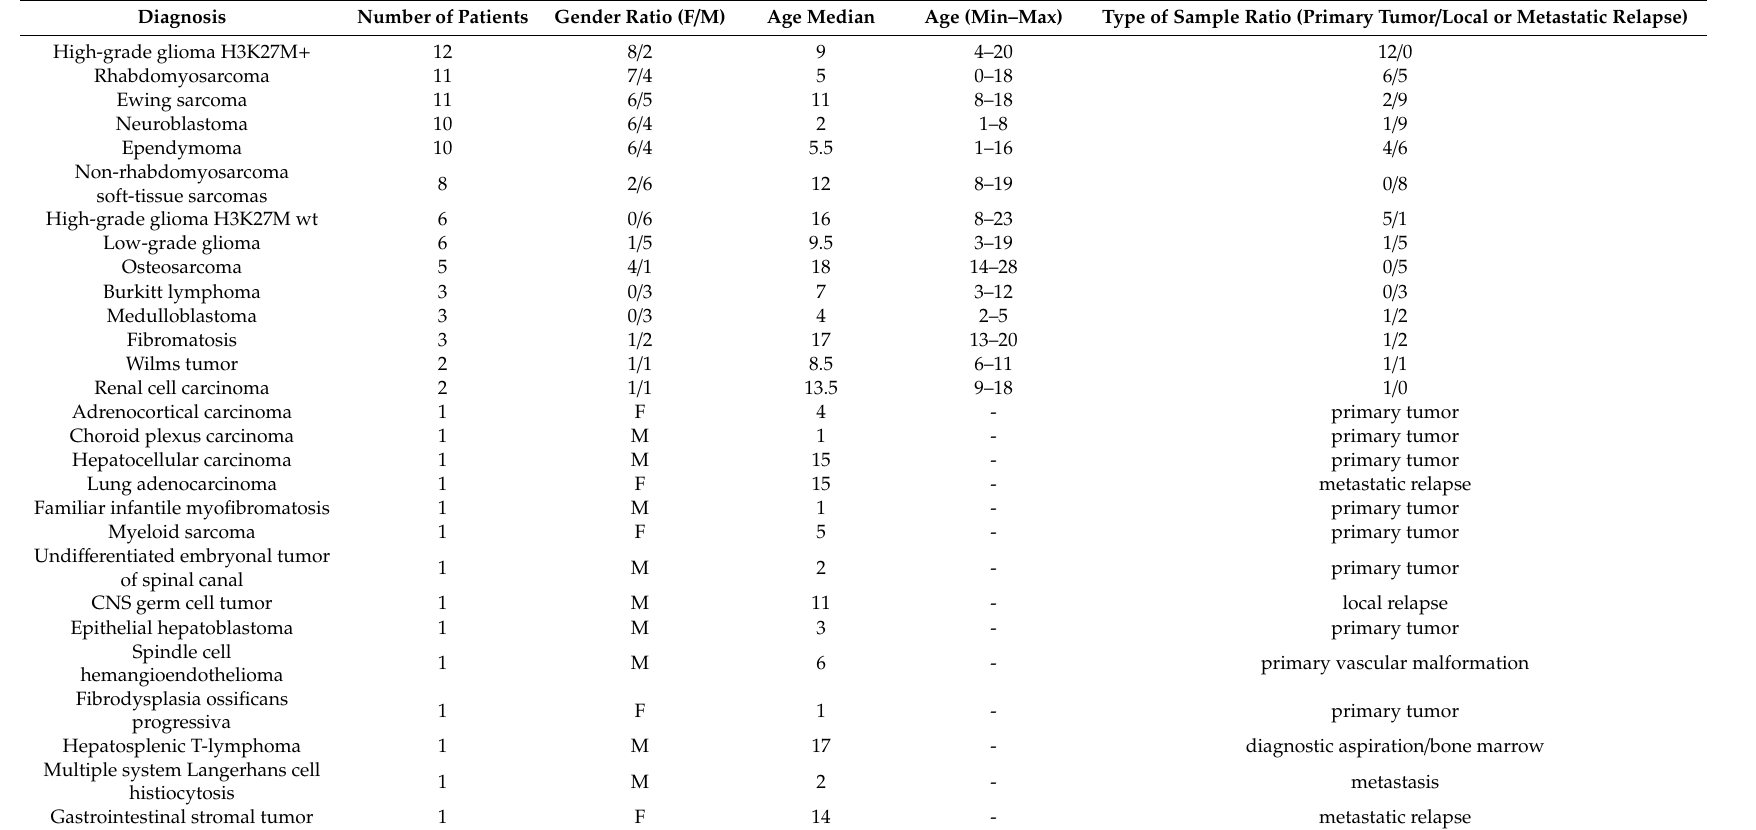
Table 5. Number of patients stratified according to their diagnoses and baseline clinical